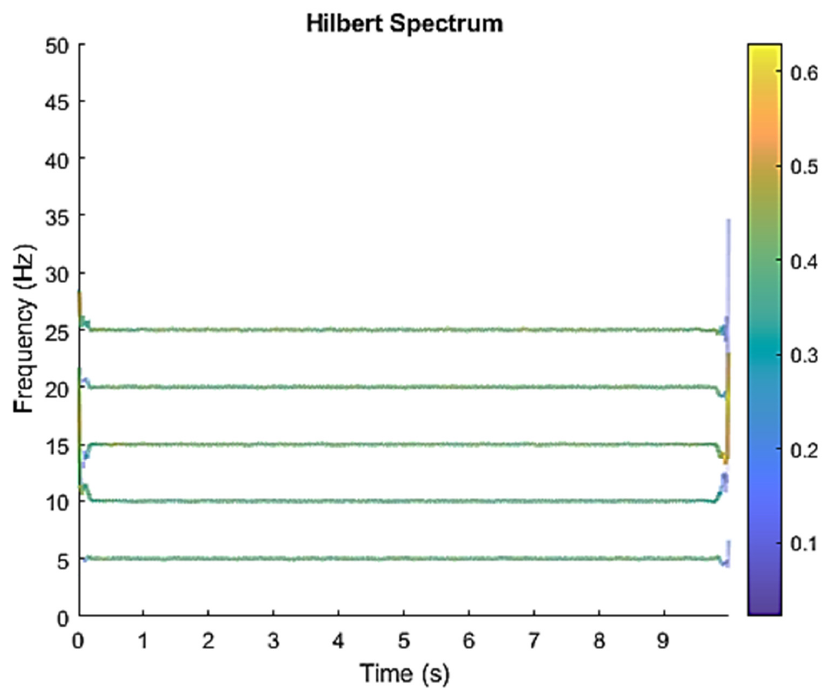
Figure 7. Analysis of data separated by ICA-VMD’s Hilbert Spectrum results.